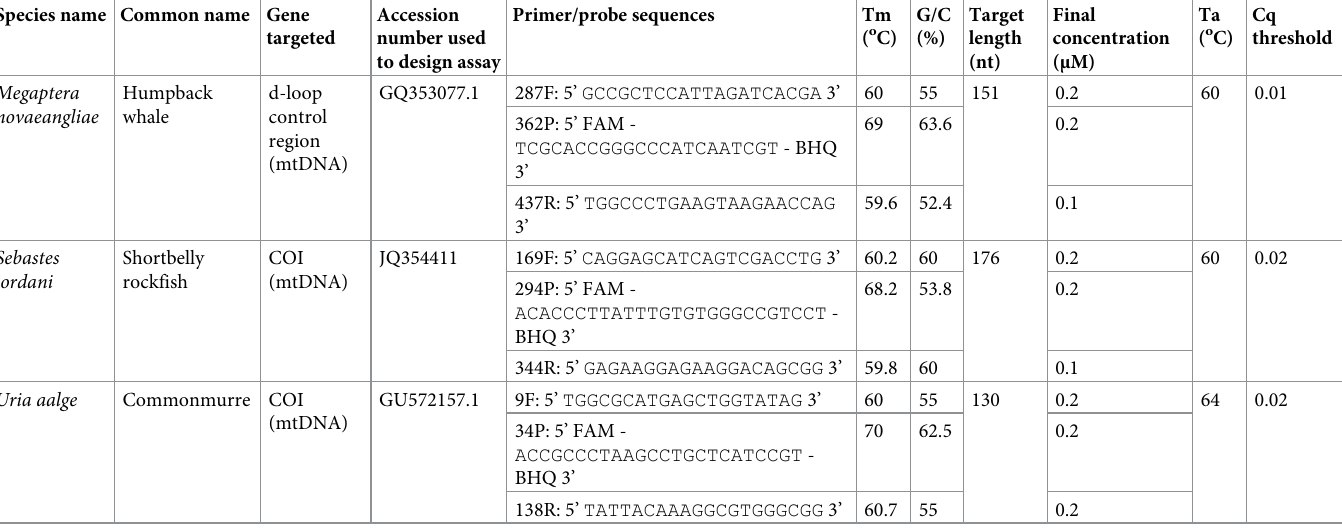
Table 2. Primers and probes designed for target organisms. Target organism, primer and probe sequences, gene target, fragment size, final concentrations of primers and probe, slope, intercept, limit of quantification, and efficiency of assay. Species name Common name Gene targeted